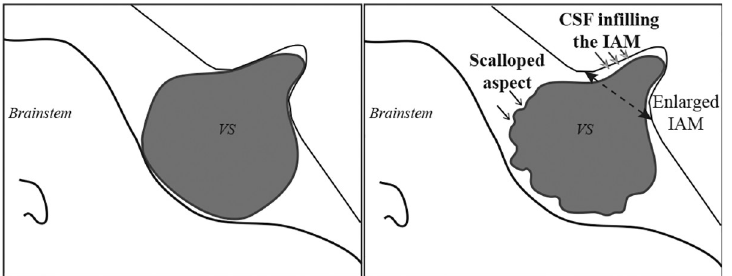
Fig 5. Diagram showing the radiological aspect of spontaneously shrinking vestibular schwannoma. The festooned aspect is easily noticeable in the medial part of the tumor. In an axial view, the CSF infilling the IAM appears as a triangle placed at its anterior part at the front of the intrameatal part of the tumor. CSF = cerebrospinal fluid; IAM = internal auditory meatus.